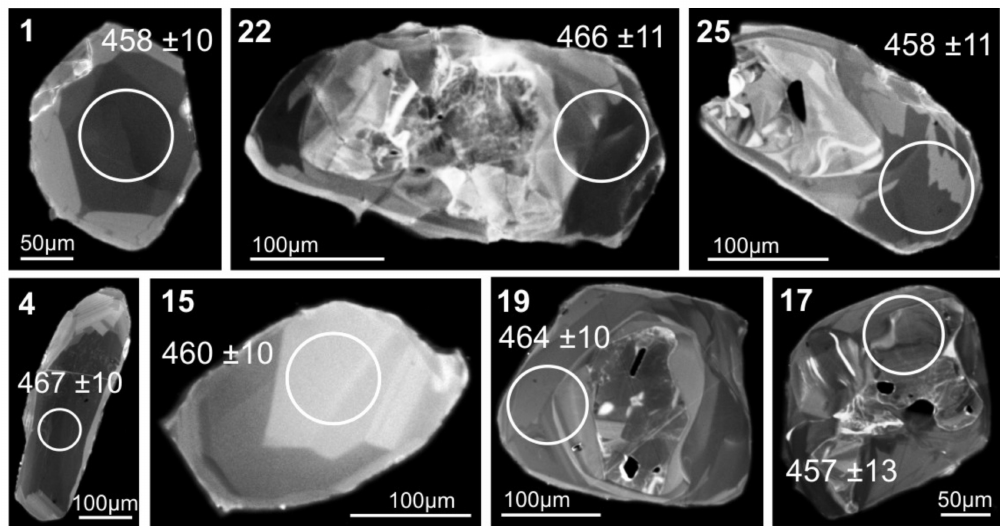
Figure 15. Cathodoluminescence (CL) images of representative zircon crystals from coarse-grained amphibole–chlorite–magnetite rocks (metamafic) in the Tog peridotite. Spot location and the respective individual 206 Pb / 238 U ages with 1-sigma uncertainty. Numbers in the left corner correspond to numbers in Table S7 in Supplementary Materials.